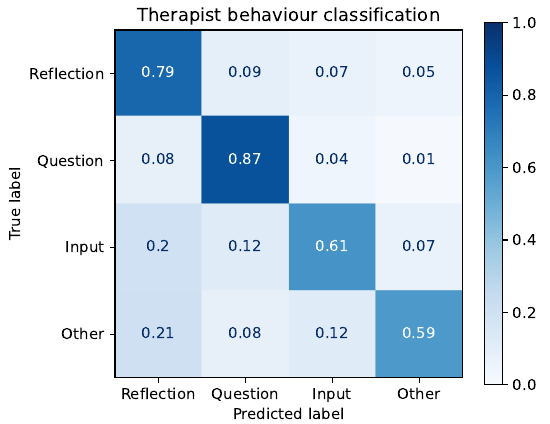
Figure 12. Confusion matrix of BERT w/ Adapters for (main) therapist behaviour prediction in the Original Unbalanced setting. Normalised by